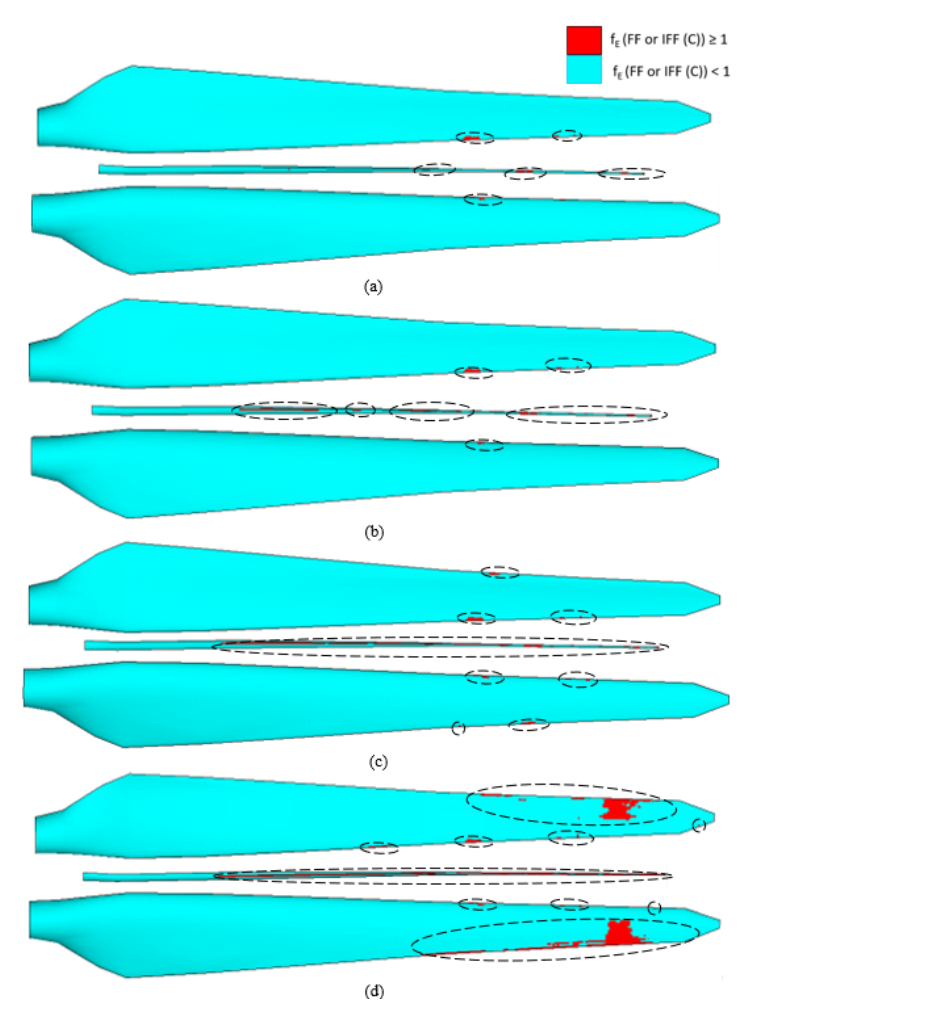
Figure 27. Element failure progression in the pressure side, internal flange and suction side of the blade (from top to bottom in a panel) at